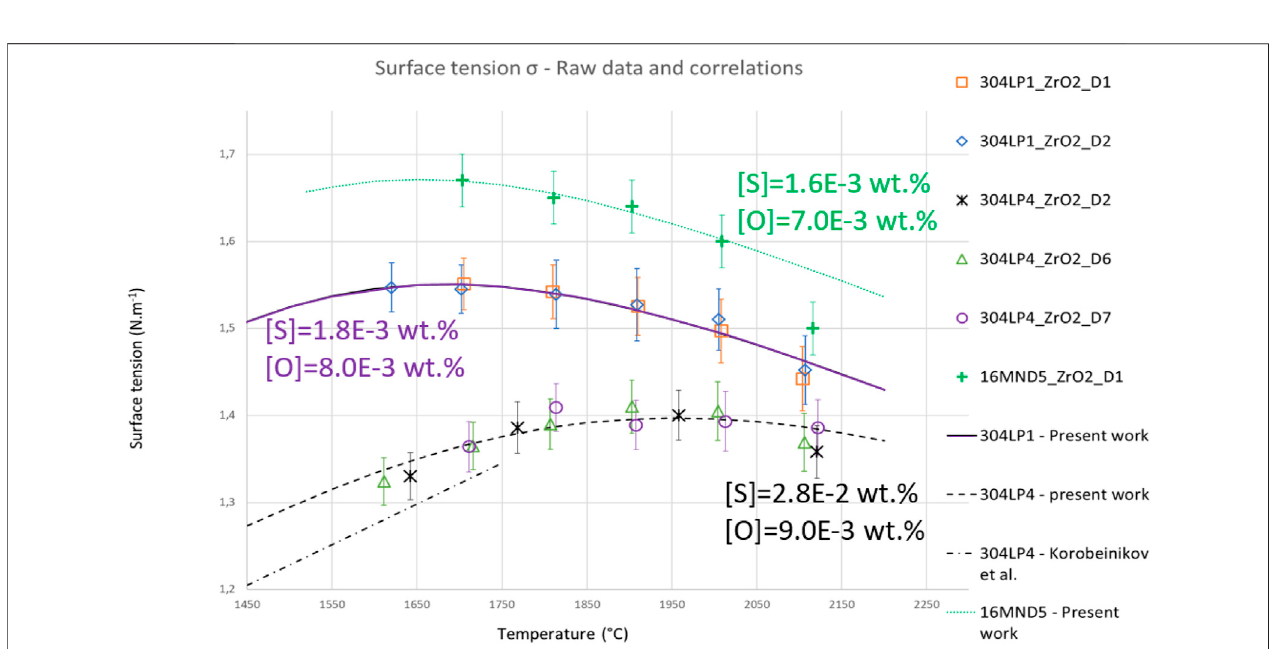
FIGURE 6 | VITI-MBP surface tension measurements and comparison with literature at “ low ” temperatures for 304L (Korobeinikov, et al., 2021; Delacroix, et al., 2022). The mass fraction of sulfur [S] and oxygen [O] related to each grade is also indicated.